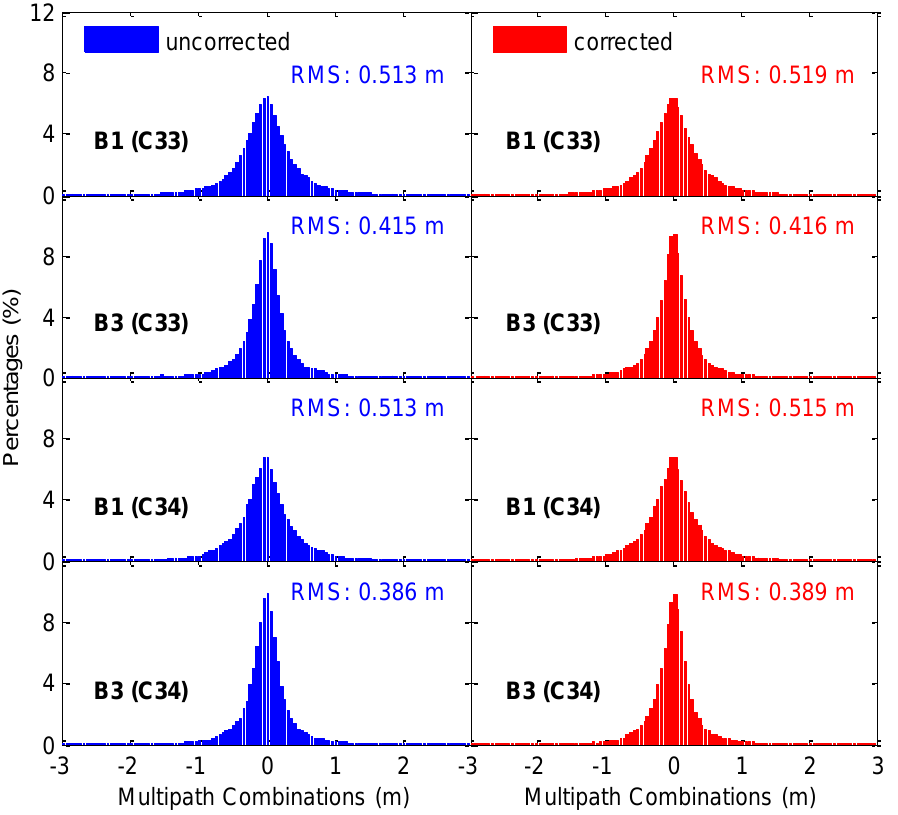
Figure 18. Distribution of uncorrected and corrected MP combination time series for BDS-3S MEO satellites.